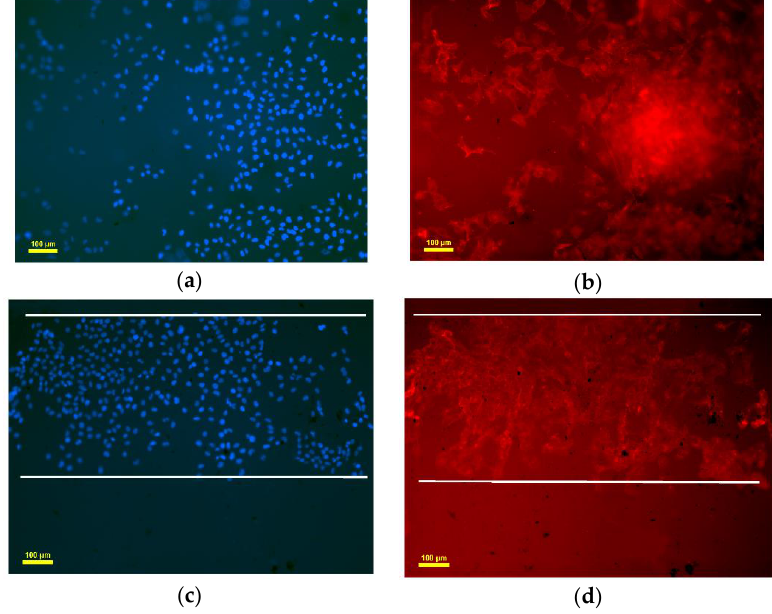
Figure 9. Group Gel-F127-PCL: ( a ) cell nucleus in the construct; ( b ) cytoskeleton in the construct; group Gel-F127: ( c ) cell nucleus in the construct; ( d ) cytoskeleton in the construct.